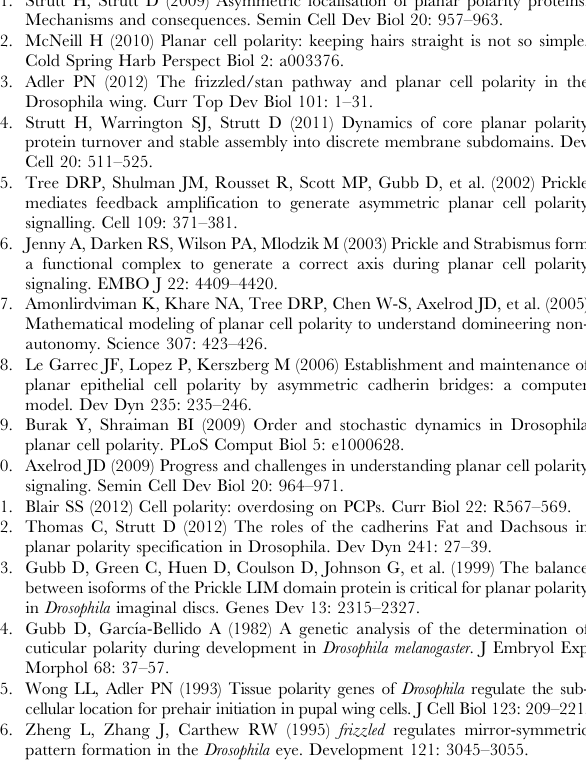
Figure S6 SkpA regulates levels of Pk at junctions. (A,B) 28 hr pupal wings expressing ptc-GAL4/ + ; skpA shRNA-HMS00657 / + , stained for Pk (green), Stbm (red) and either Fmi (blue in A) or Arm (blue in B). Yellow bar marks the ptc-GAL4 domain. Scale bar 20 m m. (TIF) Table S1 RNAi screen of HMG CoA pathway components. In the initial screen, RNAi lines were crossed to MS1096-GAL4 at 29 u C. Those lines where wings could not be mounted due to lethality or where the wings were disrupted (shrivelled or curly) were then crossed to MS1096-GAL4 at 25 u C or 459.2-GAL4 at 29 u C. Multiple wing hair phenotypes are common, and are most likely caused by large cells/cell division defects.